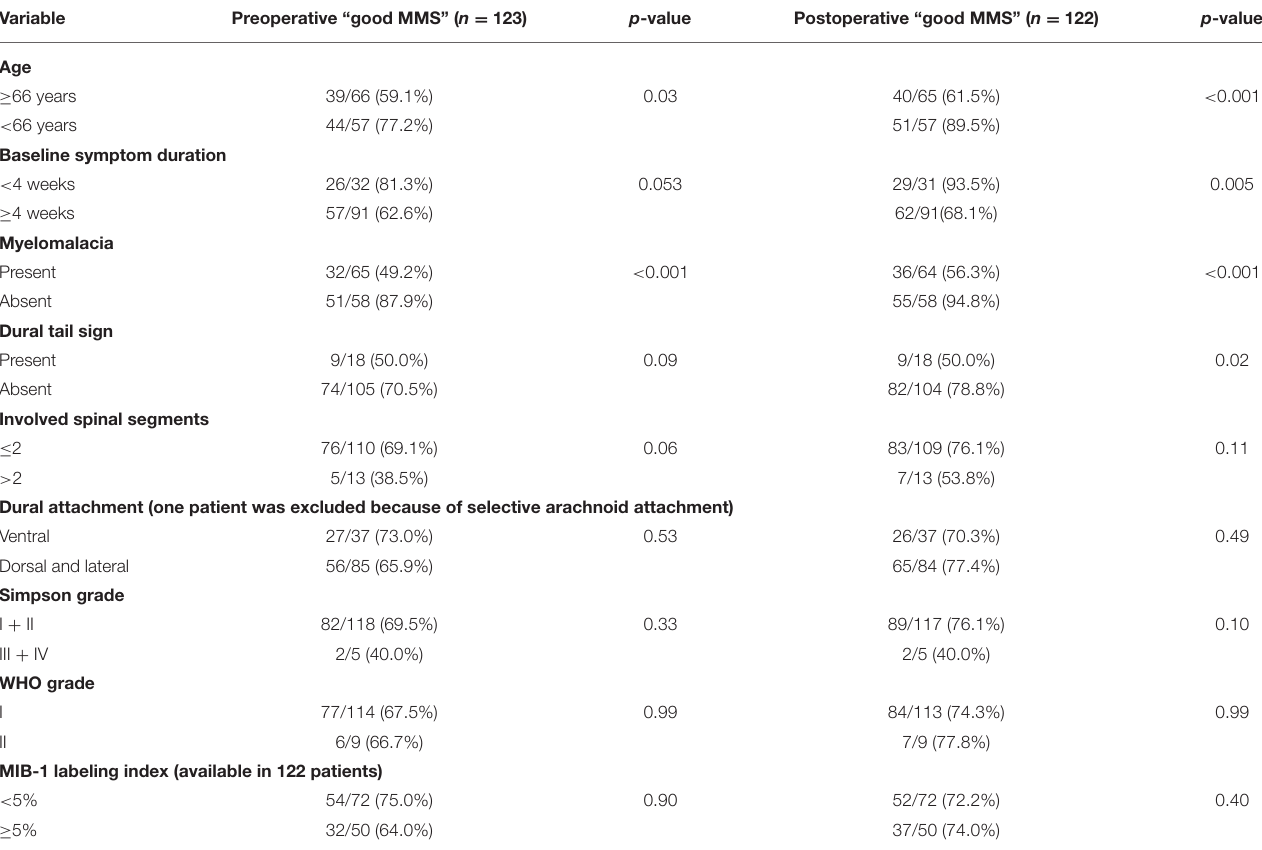
TABLE 2 | Clinical and imaging features associated with the modified Mccormick